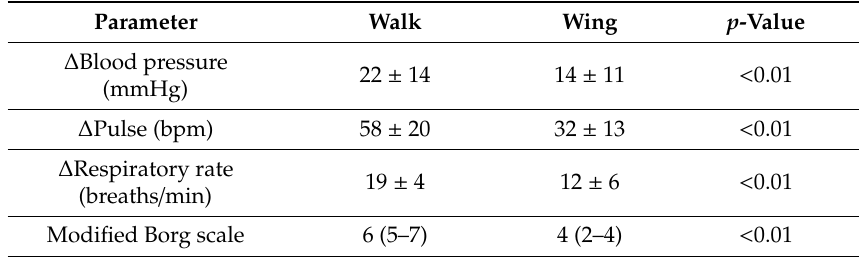
Table 1. Changes in vital signs and symptoms before and after the walk and wing methods. Parameter